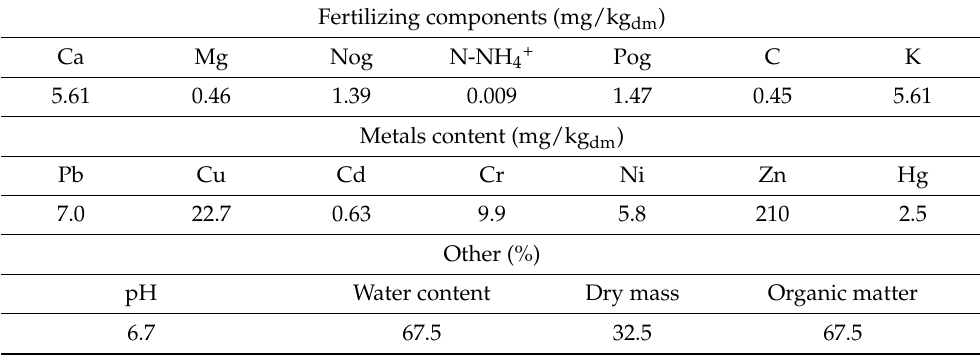
Table 2. Properties of